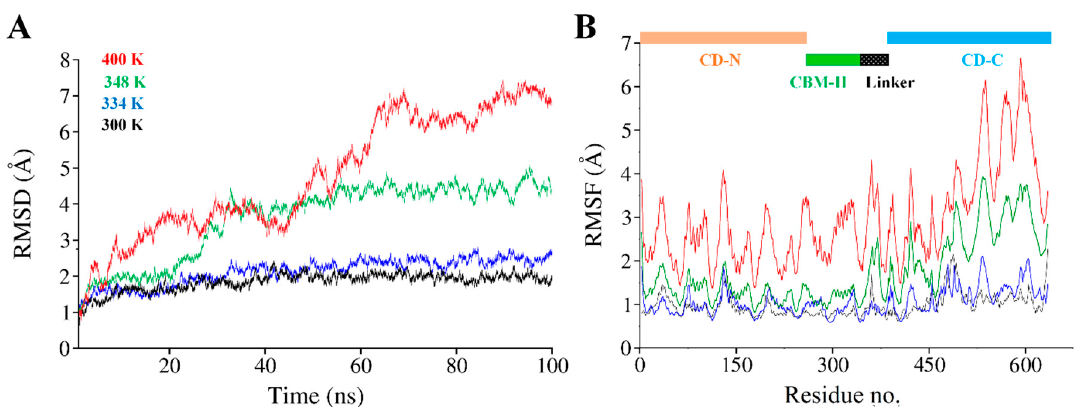
Figure 5. ( A ) Time dependent all backbone atom root mean square deviation (RMSD) of Cel6A.CBC, ( B ) Root mean square fluctuation (RMSF) as a function of residue number of Cel6A.CBC at different temperatures. Each trajectory is colored as follows: 26.85 °C (black), 60.85 °C (blue), 74.85°C (green), and 126.85 °C (red).